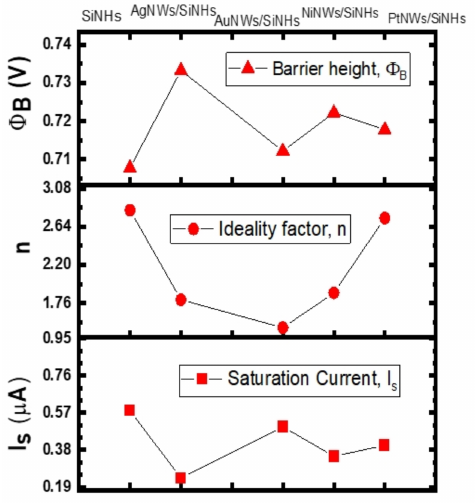
Figure 4. Schottky-diode parameters of MeNWs/SiNHs-based devices. Next, the photoresponse of the devices based on MeNWs/SiNHs was measured under zero bias conditions by applying different optical powers varying from 0.01 to 100 mW cm − 2 (Figure 5a–d). The photocurrent response showed a strong intensity- dependent behavior with a good linearity from lowest to highest power region. The dependence was fitted by a power law (I PC ∝ P θ ), where P is the light power and θ repre- sents its exponent correlated to the photoresponse, with relatively large exponent values varying from 0.77 for PtNWs/SiNHs to 1.22 for AgNWs/SiNHs, whereas the greater than 1 value for the exponent is associated with dynamic plasmonic effects. In the framework of Rose theory [44], such close to integer values reveal the photoresponse is mostly propor- tional to the photogenerated carriers with a very low limitation caused by defect states or trapping centers. The results indicate MeNWs/SiNHs-based devices are able to operate in self-bias mode with a broad linear characteristic of the photoresponse, which is suitable for a variety of visible photodetection applications.